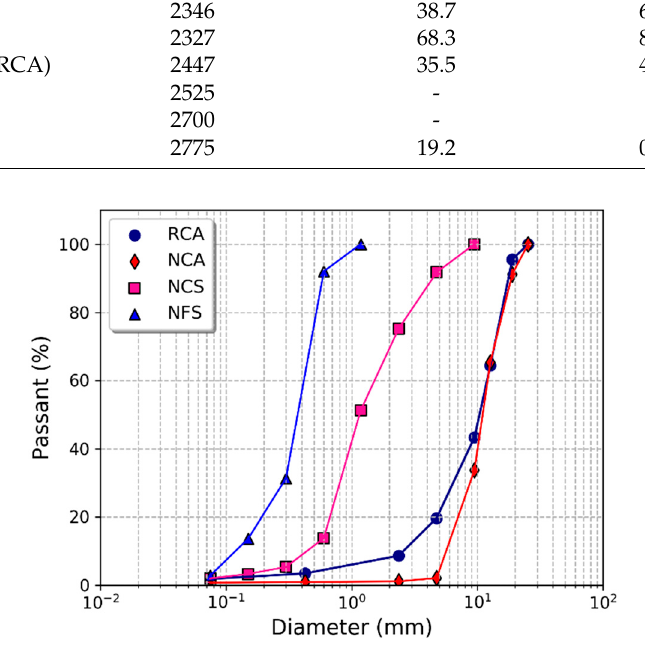
Figure 1. Particles size distribution of used